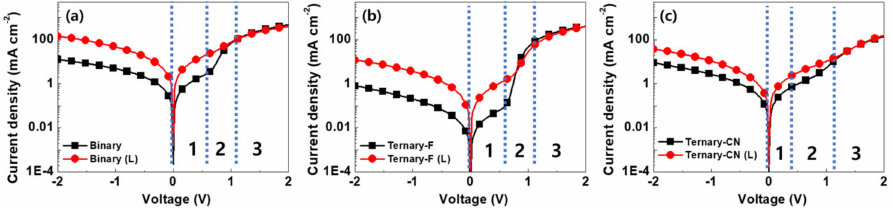
Figure 6. J-V characteristics of ( a ) Binary, ( b ) Ternary-F, and ( c ) Ternary-CN before (solid square) and after (solid circle) the light-soaking